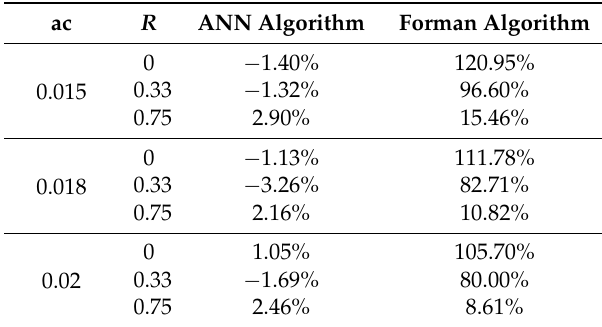
Table 8. The errors of the results by two